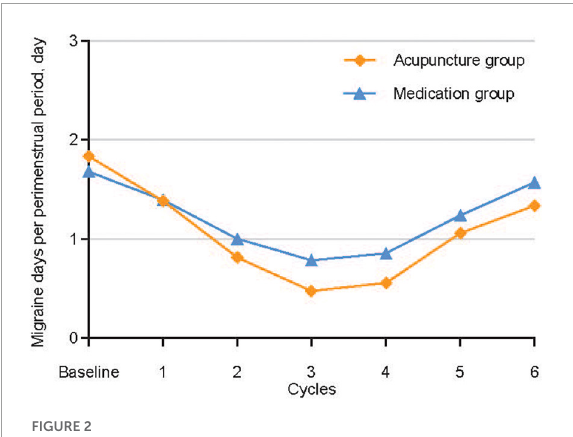
FIGURE2 Primary outcomes throughout the